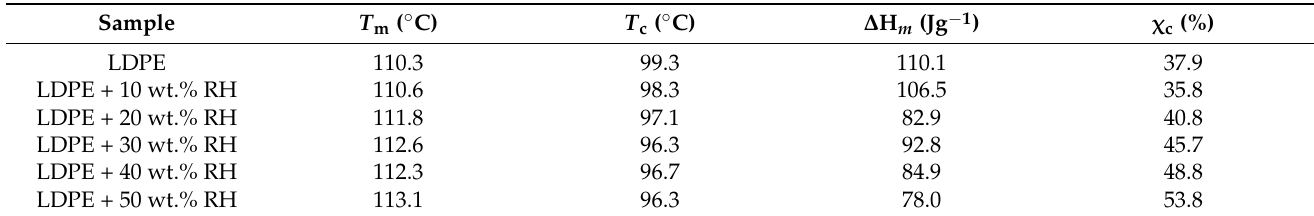
Table 5. Results of DSC measurement for the neat LDPE and LDPE/RH biocomposites.